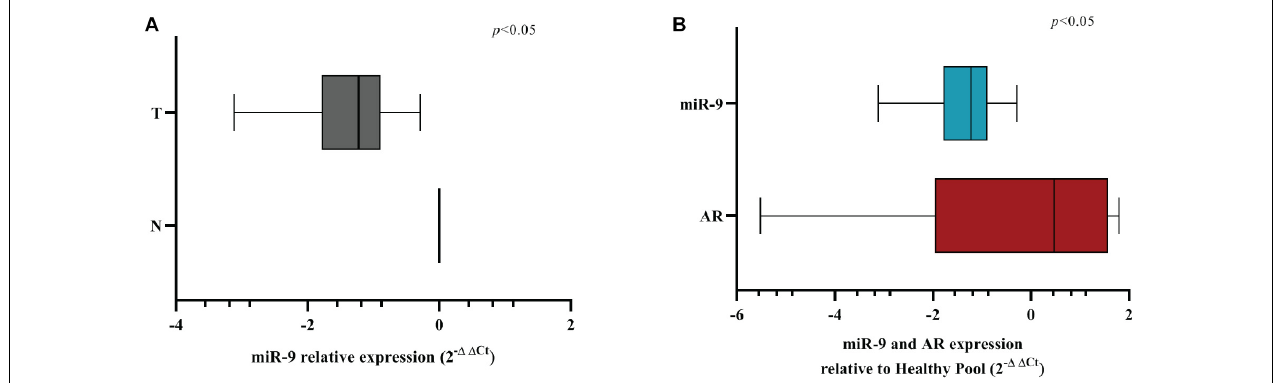
FIGURE 8 | MiR-9-5p is downregulated in BC FFPE samples. (A) Box-plot representation of the miR-9-5p (miR-9) qRT-PCR expression in adjacent normal (N) vs. tumoral (T) samples for all FFPE samples examined ( n = 11). (B) Box-plot representation of the miR-9-5p (miR-9) and AR qRT-PCR expression in all FFPE samples examined ( n = 11). The expression of AR and miR-9 have been normalized to GAPDH and RNU44, respectively. A non-parametric unpaired t -test (Kolmogorov-Smirnov test) method in (A , B) . Box-plots have been presented on a